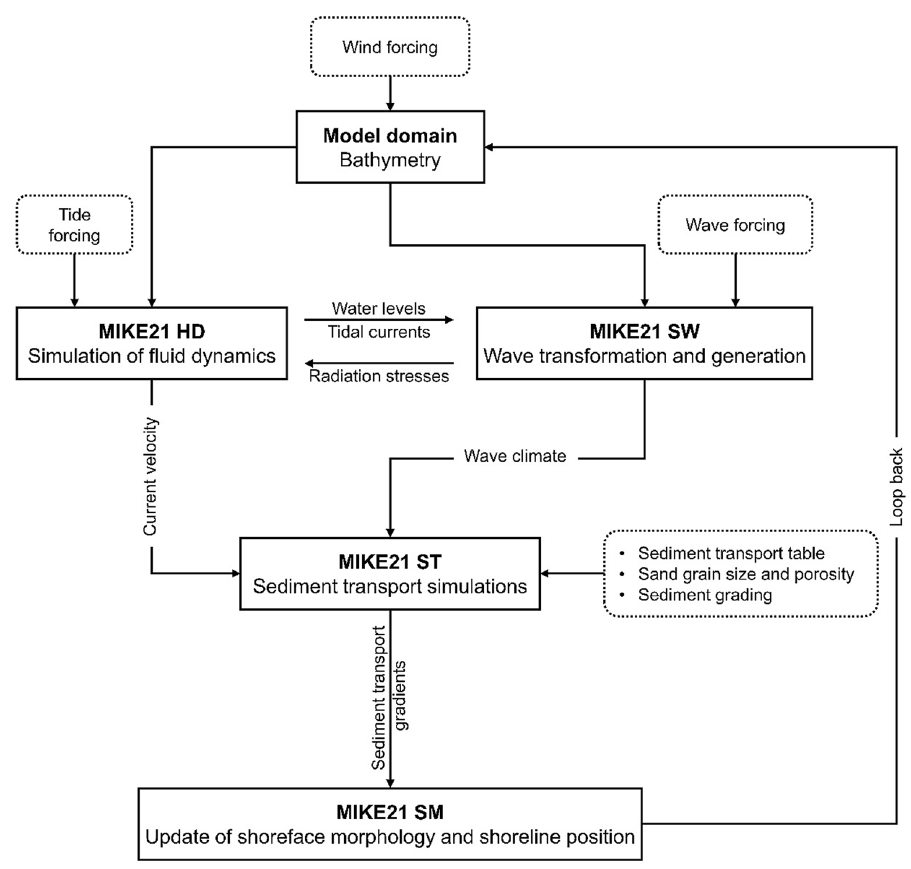
Figure 2. Computational framework of MIKE21 51 . MIKE21 SW and MIKE21 HD simulate the wave and flow field on a finite volume mesh, respectively. MIKE21 ST simulates the littoral drift gradients in response to the wave and flow fields, and MIKE21 SM uses the littoral drift gradients to update the shoreline position at each time-step based on the one-line theory (Fig.